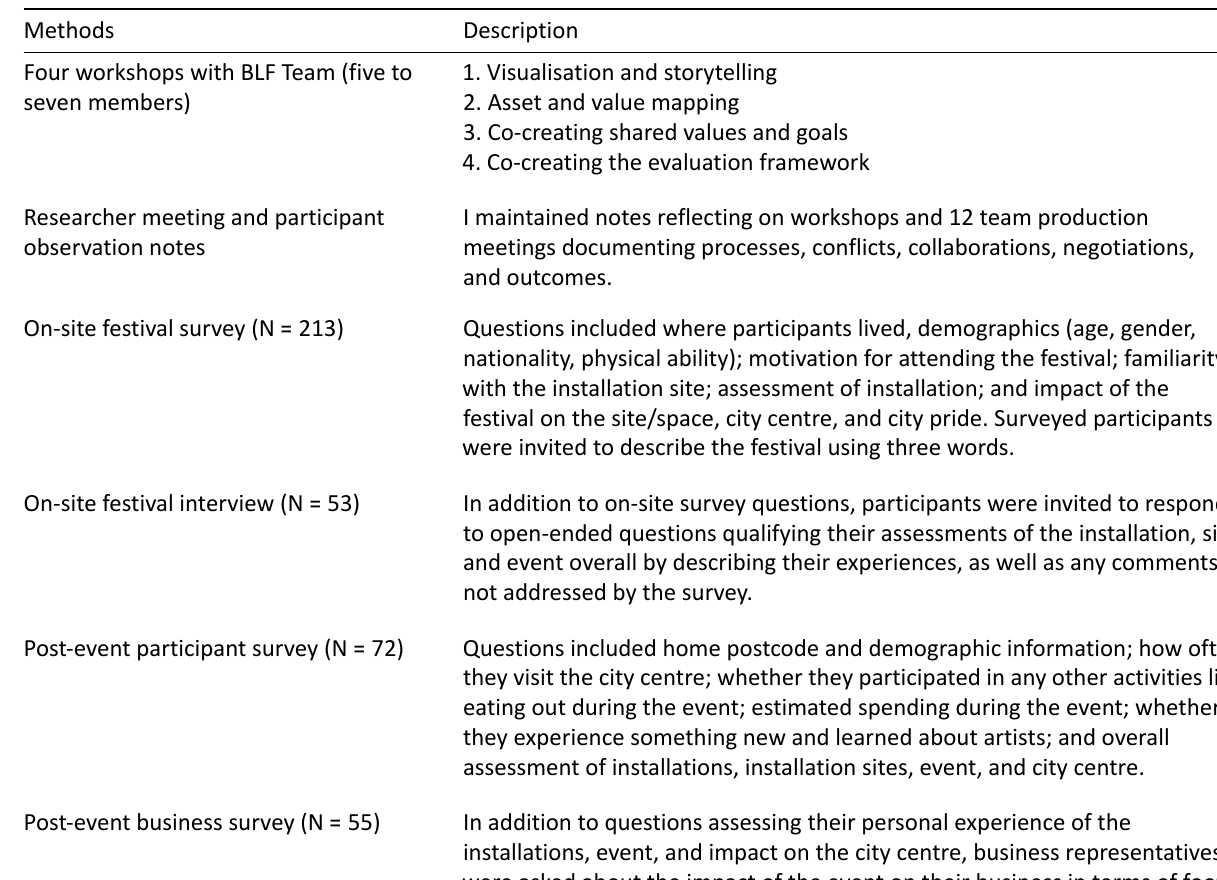
Table 1. Description of research